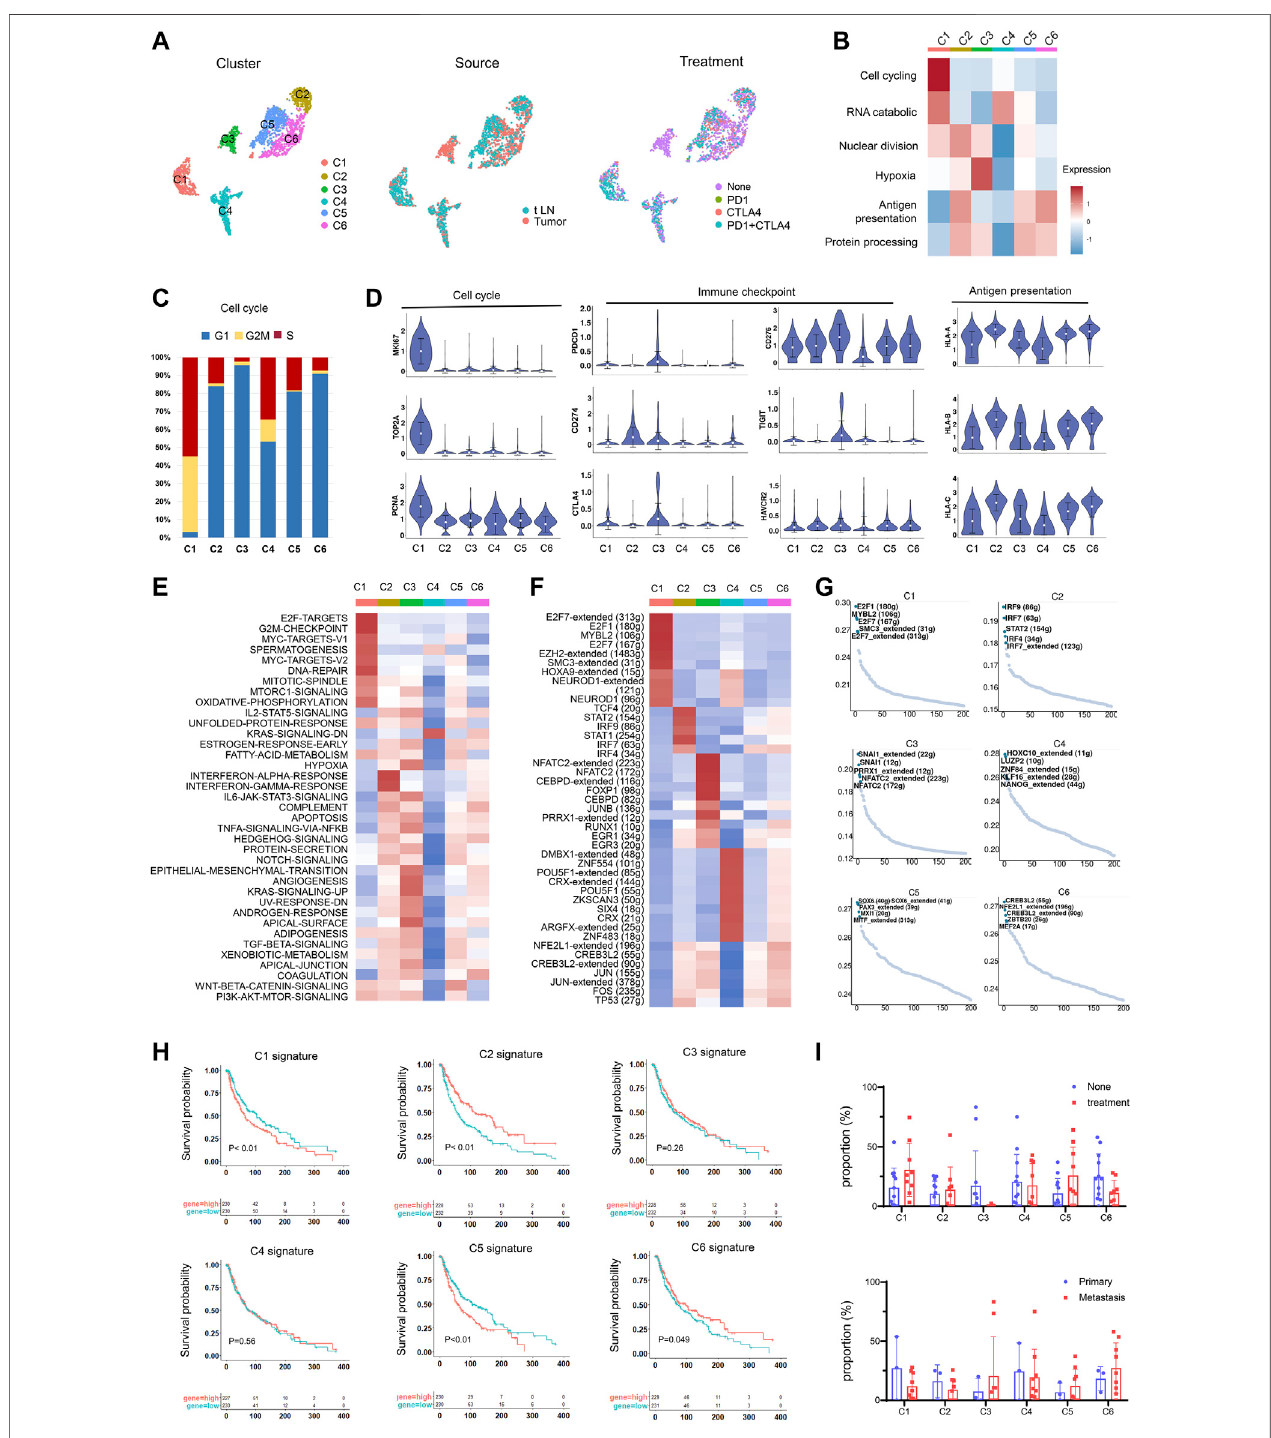
FIGURE3| Identi fi cation oftumor cellsubtypes. (A) UMAP plotshowing thesixsubgroups generatedfromtumor cells.Cells werefurthershown indifferentcolors by patient origin. (B) Differences in the malignant signature scored by ssGSEA between tumor subsets. (C) Bar plots showing the fraction of cell cycle (G1, G2M, S) in tumorsubsets. (D) Violinplotsoftheexpressionlevelsofcellcyclegenes,immunecheckpointgenes,andtheHLAgenesintumorsubsets. (E) Differencesinthehallmark gene set scored per cell byGSVA in tumor subsets. (F) Heatmap of thet values ofAUC scoresof expression regulation byTFs, as estimated using SCENIC for the cluster. t values from a linear model for the difference between cells from one cluster and cells from all other clusters, corrected for the patient of origin, and all TFs, are shown. Numbers within brackets indicate the (extended) regulons for respective TFs. (G) TF motif variability analysis in tumor subsets. The dot plot shows the rank- sortedTFmotifsaccordingtothespeci fi cscoreofTFs. (H) Kaplan – Meiercurvesforprogression-freesurvivalaccordingtohighvs.lowexpressionoftheclustersignature score evaluated by ssGSEA. (I) Proportions of tumor subsets in primary and metastatic tumors and non-treatment group and treatment group.